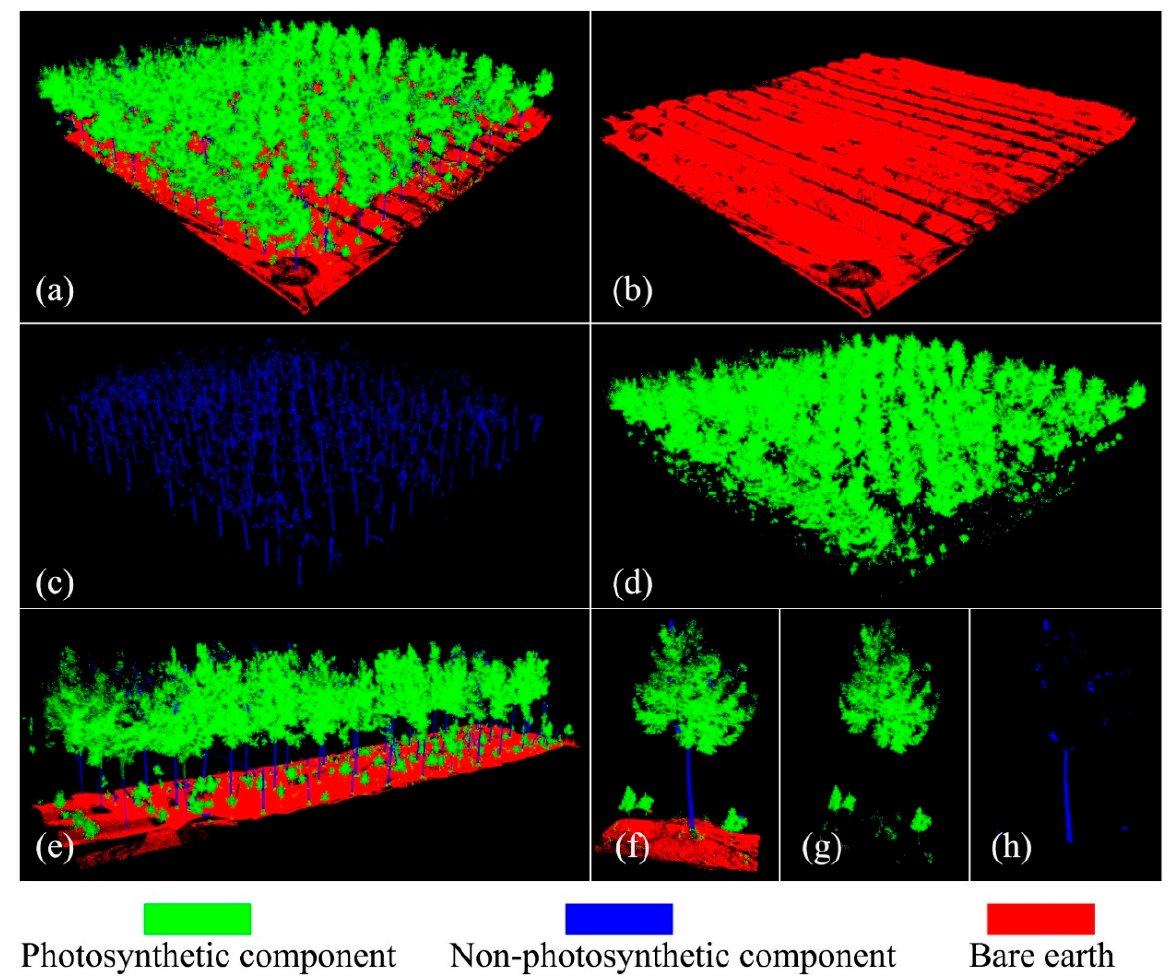
Figure 5. The classified fused point data for the study forest plot (inset a ) including the bare earth (inset b ), non-photosynthetic component (inset c ), and photosynthetic components (inset d ). Additionally, subplot (inset e ) and individual tree (insets f – h ) point cloud data of the study forest plot are shown in perspective and side-lateral views separately to better illustrate the classification results.